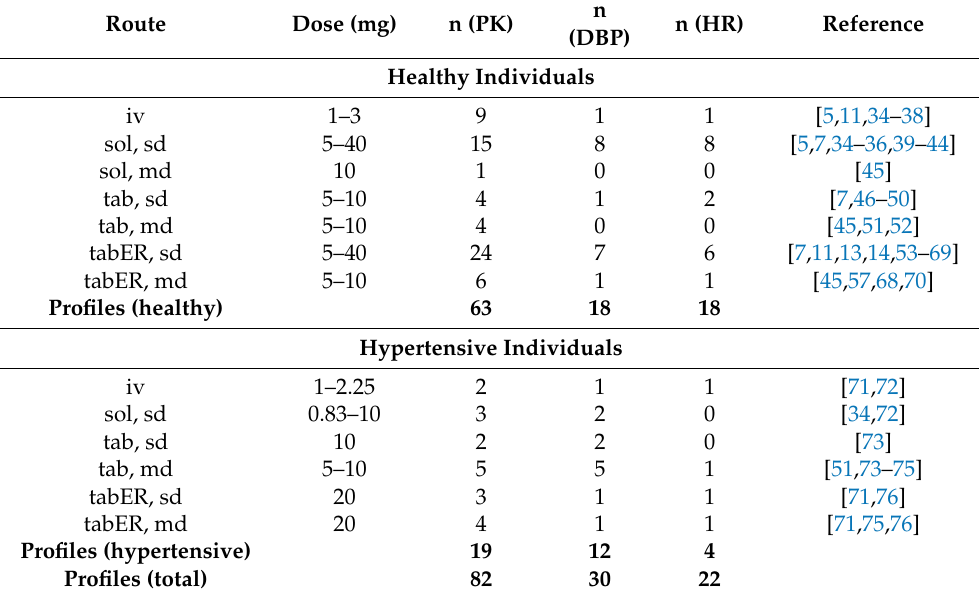
Table 1. Additionally, 12 concentration–time profiles of the metabolite dehydrofelodipine were reported. A detailed overview of all clinical studies involved, including administration protocols, the demographics of the participants, and the assignment to the test or training dataset is provided in the Supplementary Materials Table S1. Table 1. Clinical studies used for the development of the felodipine PBPK/PD model.